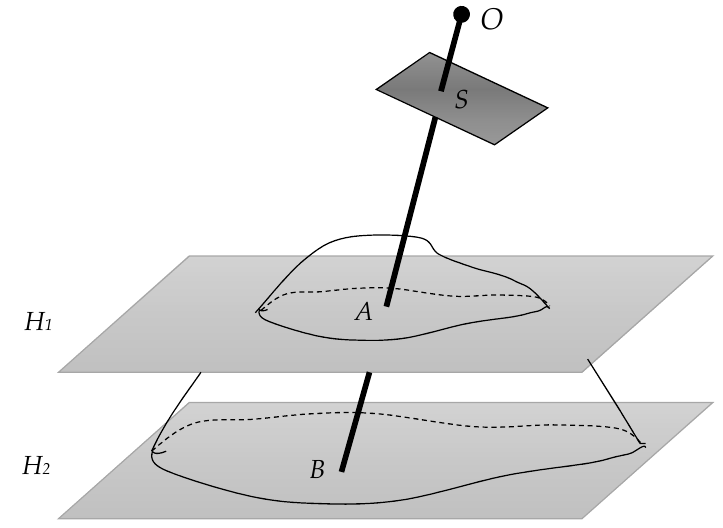
Figure 1. Principles for calculating the viewing direction.